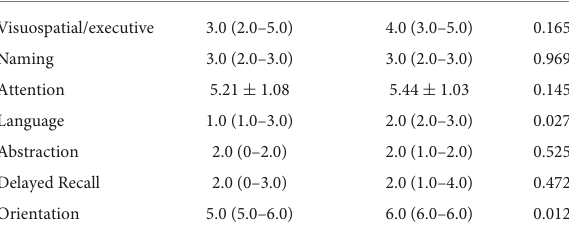
TABLE 3 Cognitive domains in MoCA of the PD patients with and without